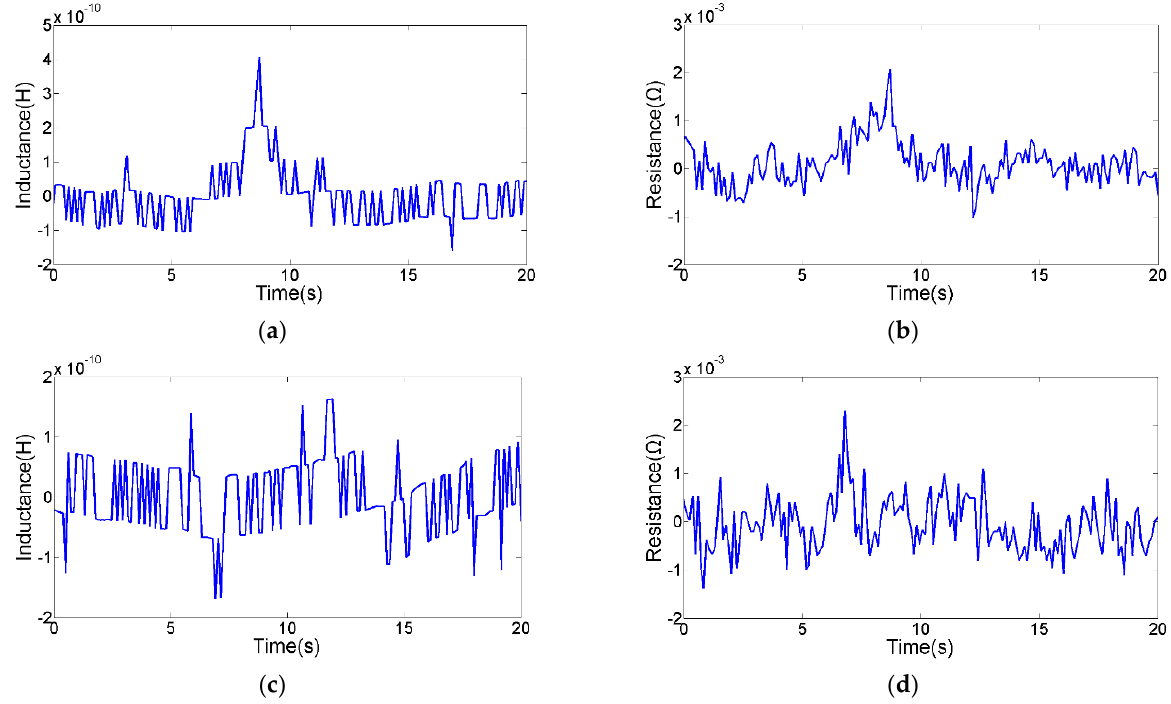
Figure 11. The detection floor level of resistance parameter. ( a ) The inductance signal of 40 µ m iron debris, ( b ) the resistance signal of 40 µ m iron debris, ( c ) the inductance signal of 70 µ m copper debris, ( d ) the resistance signal of 70 µ m copper debris.